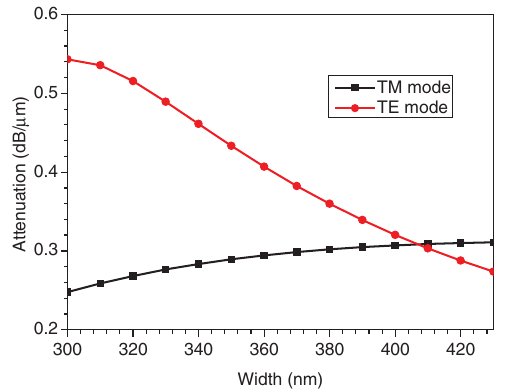
) of the modulator eff